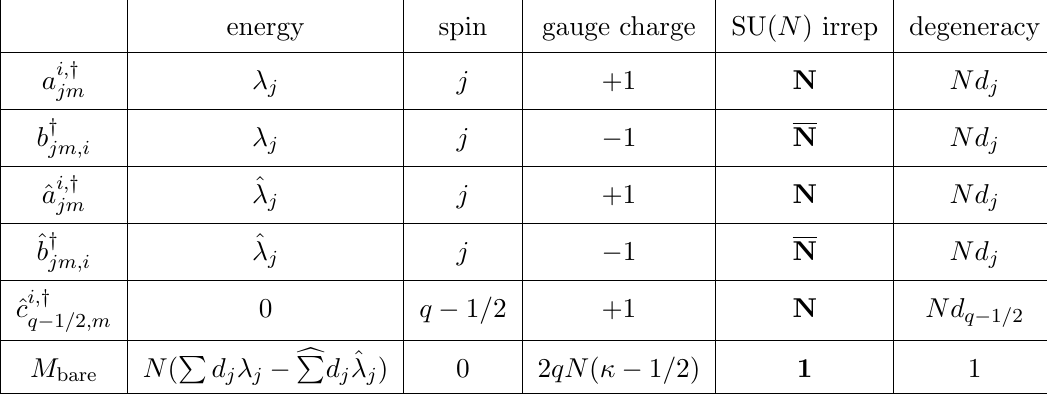
Table 4 . Properties of modes and the bare monopole in N = 1 SQED 3